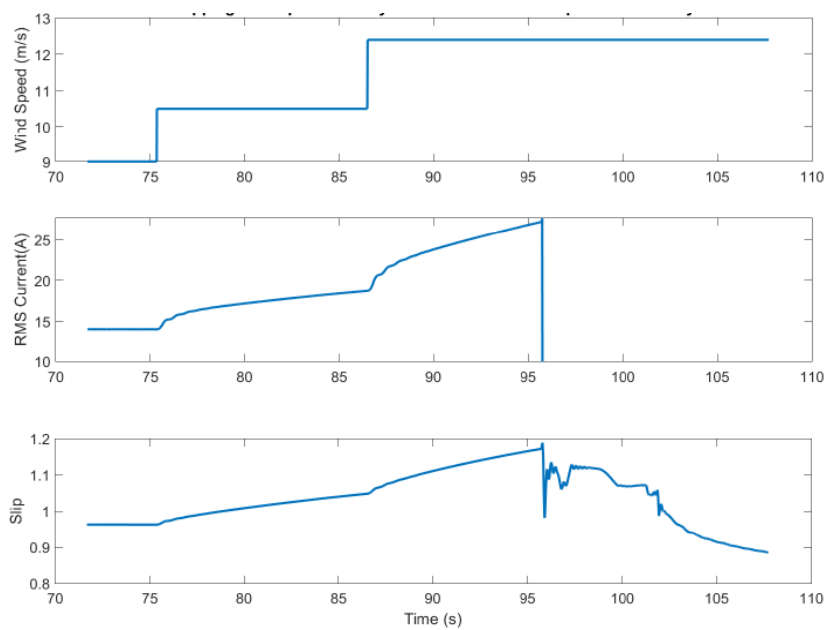
Figure 14. Time domain simulation representing false-tripping due to wind speed variation in the DFIG system.